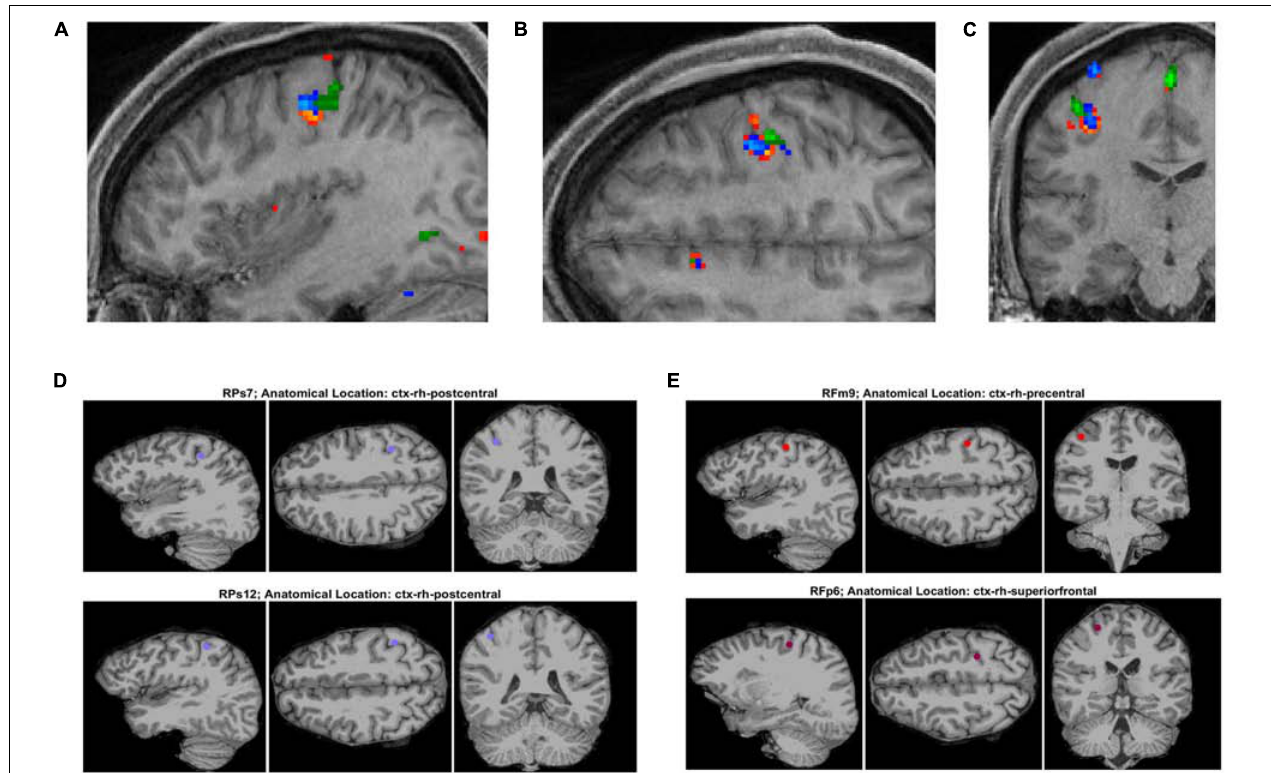
FIGURE 2 | Functional MRI and post-surgery CT images for participant P3 related to finger tasks. (A–C) Functional MRI images in orthogonal planes (sagittal, transverse, and coronal) obtained during button press task for digits 1 (orange-red), 2 (blue), and 3 (green). (D,E) Post-surgical CT images of SEEG electrode sites found to have a repeatability metric (MCC) value greater than 0.6 (for time range of 0–4.4s with respect to cue onset) for flexion of digits 1 and